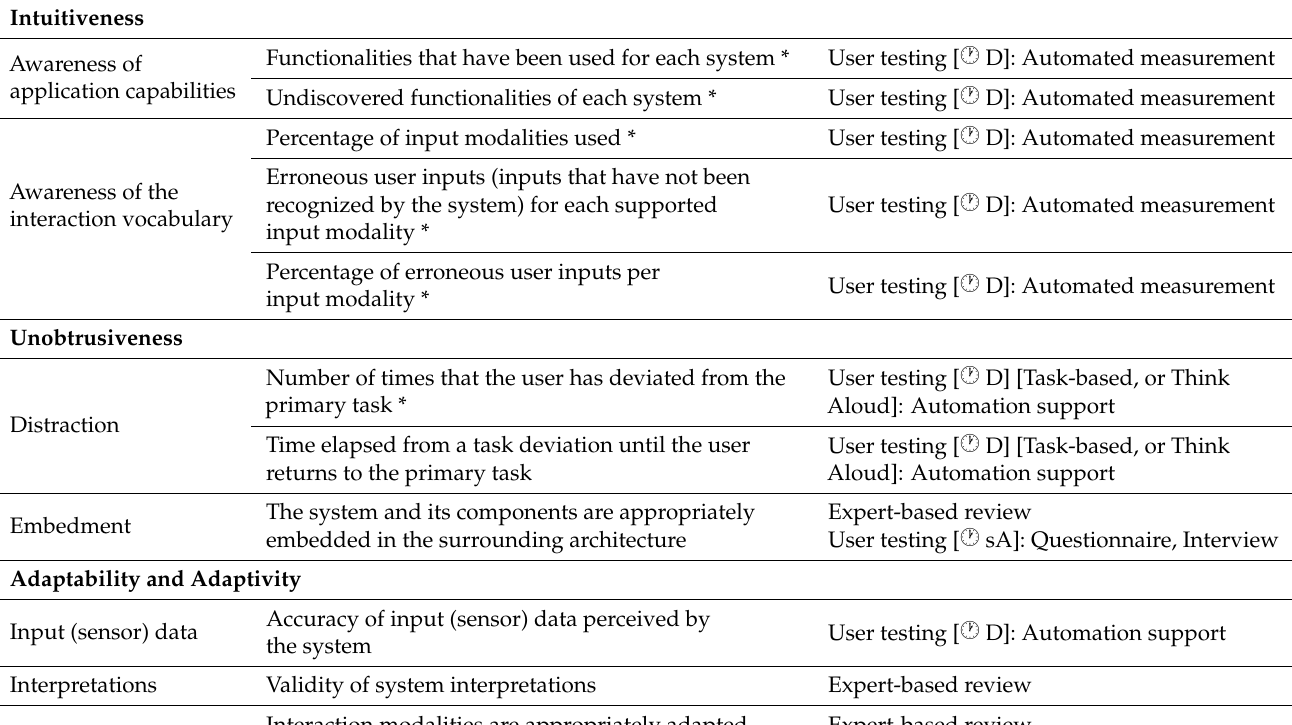
Table 1. The UXIE framework: concepts, attributes, metrics and methods. Asterisk (*) denotes metrics that are novel in the UXIE framework.